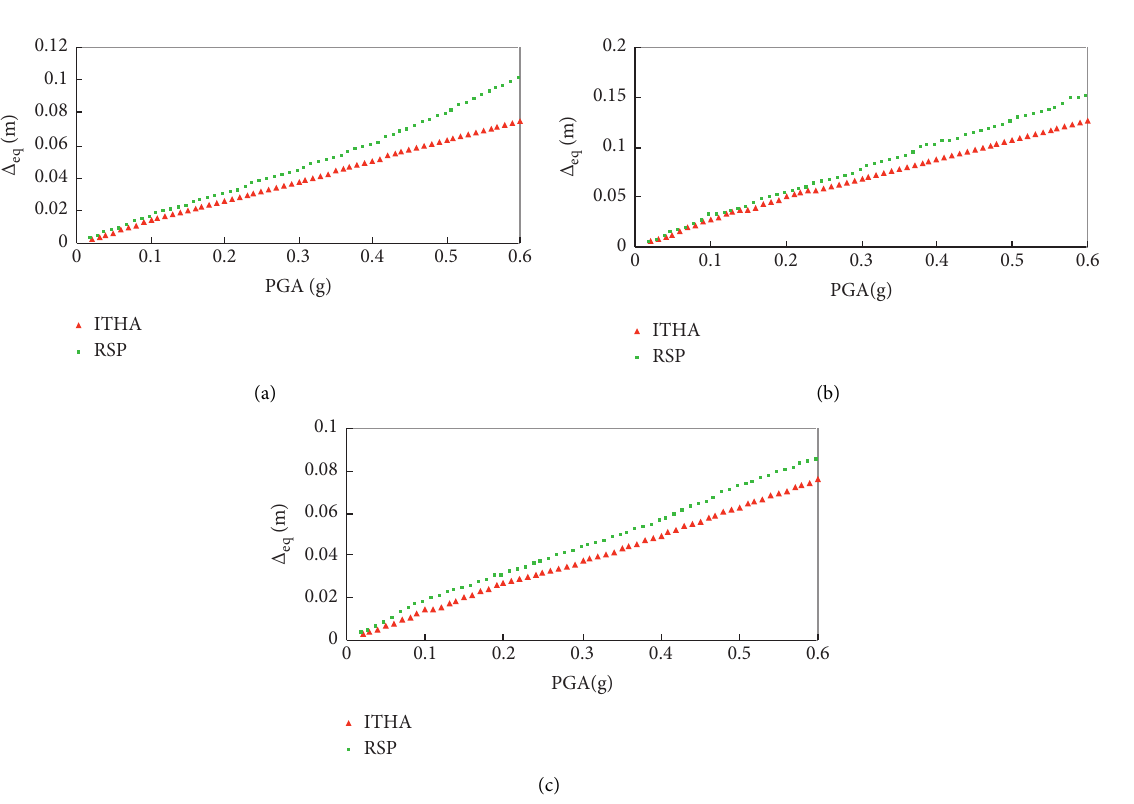
Figure 5: Comparison of the equivalent SDOF system’s displacement by ITHA and RSP: (a) 051005 bridge, (b) 100510 bridge, and (c) 050505